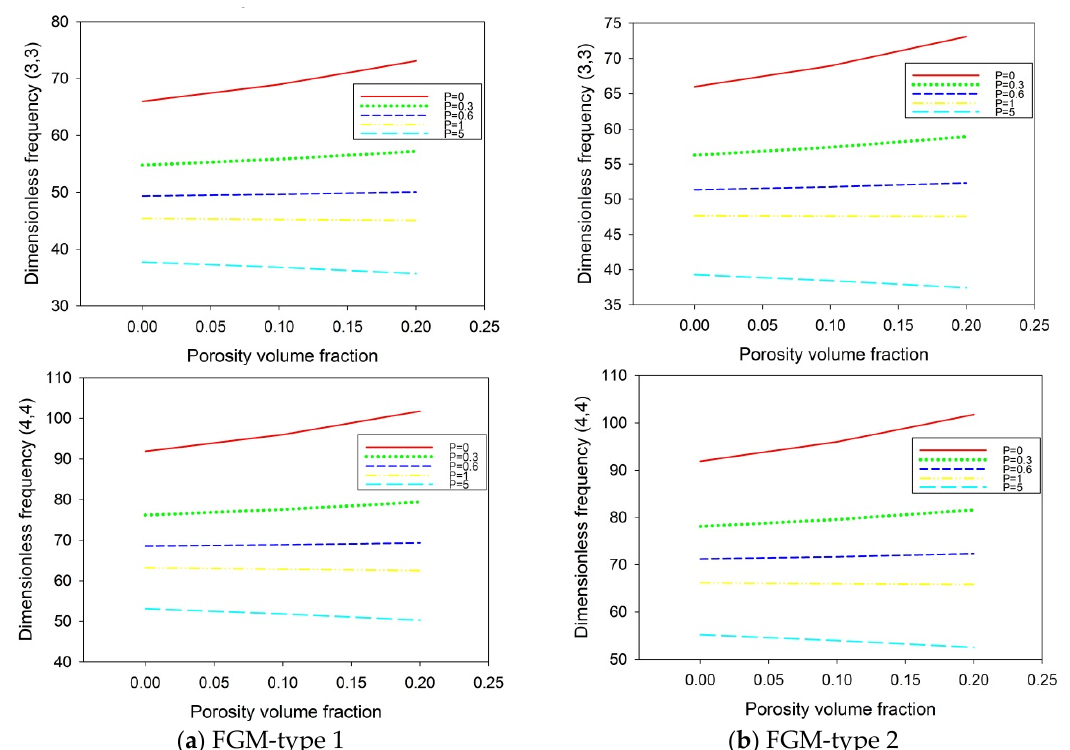
Figure 6. Dimensionless frequency of FG porous hyperbolic circular cylindrical shell against different power ‐ law indices and porosity volume fractions distributions: ( a ) FGM ‐ type 1; ( b ) FGM ‐ type 2. Appl. Sci. 2017 , 7 , 1252